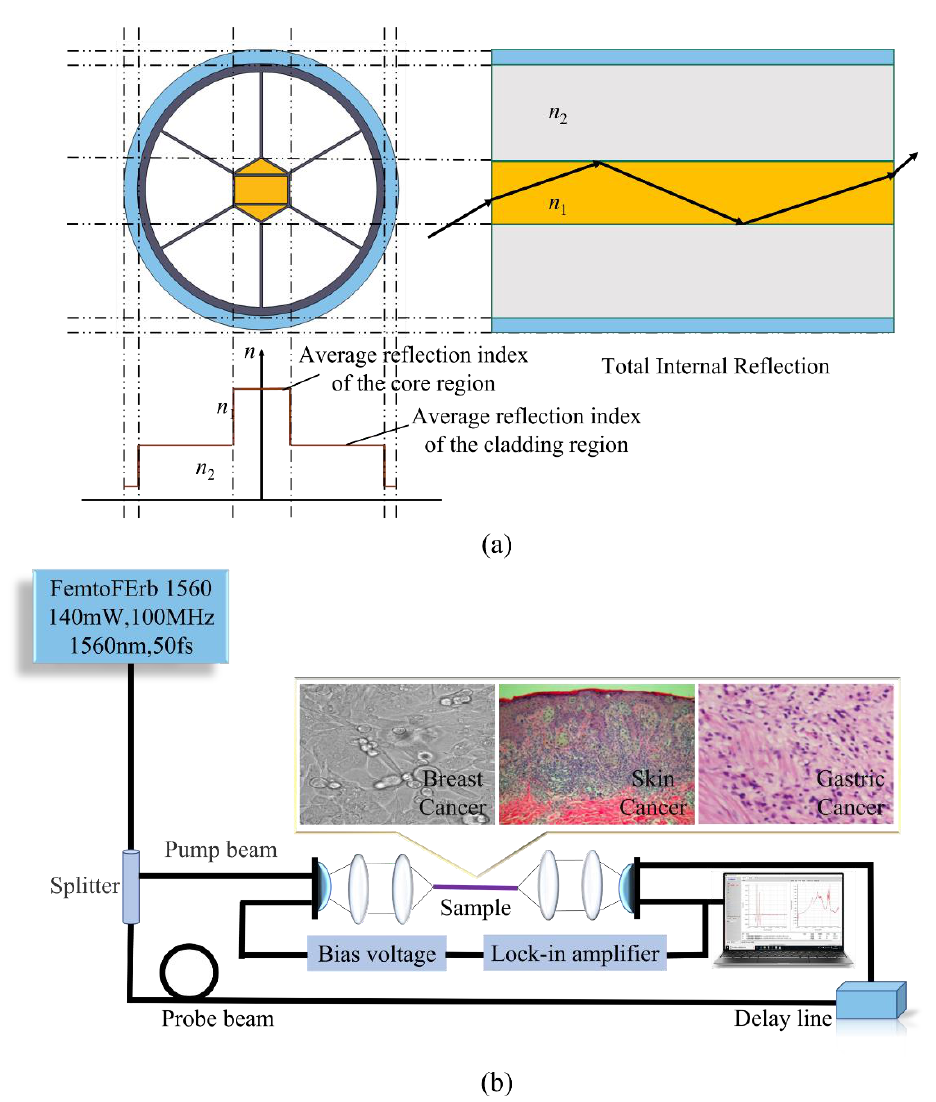
Figure 2. Principles of the MSF biosensor. ( a ) Schematic diagram of refractive index distribution and total internal reflection inside the PC-MSF. ( b ) Experimental layout using THz-TDS for cancer cells detection.